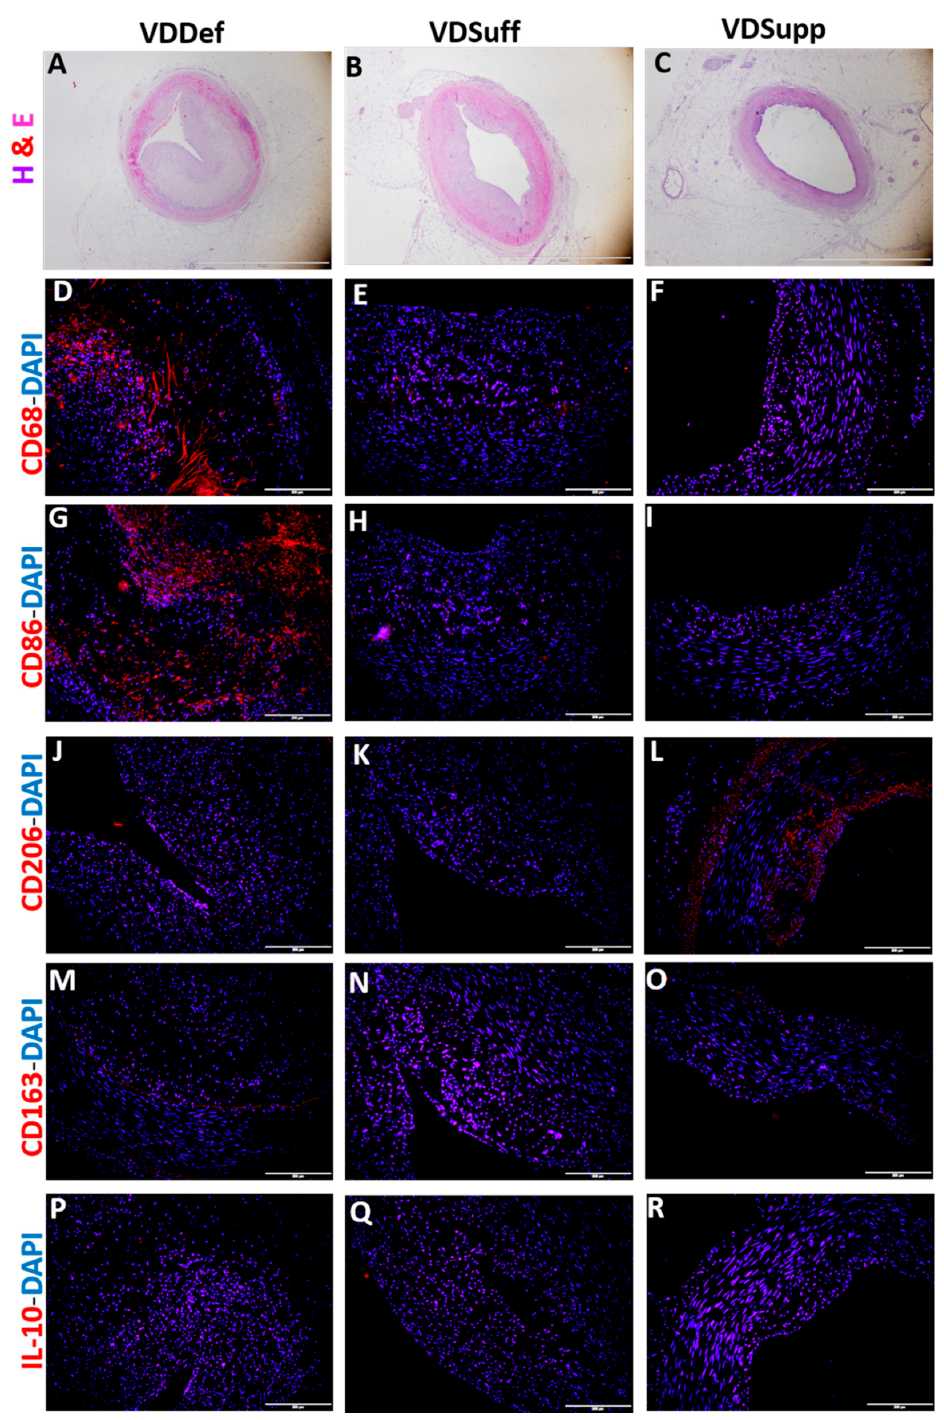
Figure 4. Immunofluorescence for macrophages in coronary arteries with angioplasty. Immunofluorescence staining for macrophages (CD68+ cells, panel D ), M1 macrophages (CD86+ cells, panel G ), M2a macrophages (CD206+ cells, panel J ), M2b macrophages (CD163+ cells, panel M ), M2c macrophages (IL-10+ cells, panel P ); 4 ′ ,6-diamidino-2-phenylindole (DAPI, panels E , H , K , N , and Q ); merged images (panels F , I , L , O , and R ). Panels A , B , and C are H & E images for the corresponding arteries in VDDef, VDSuff, and VDSupp groups. All immunofluorescence images were scanned at 200 µ m and H & E images at 100 µ